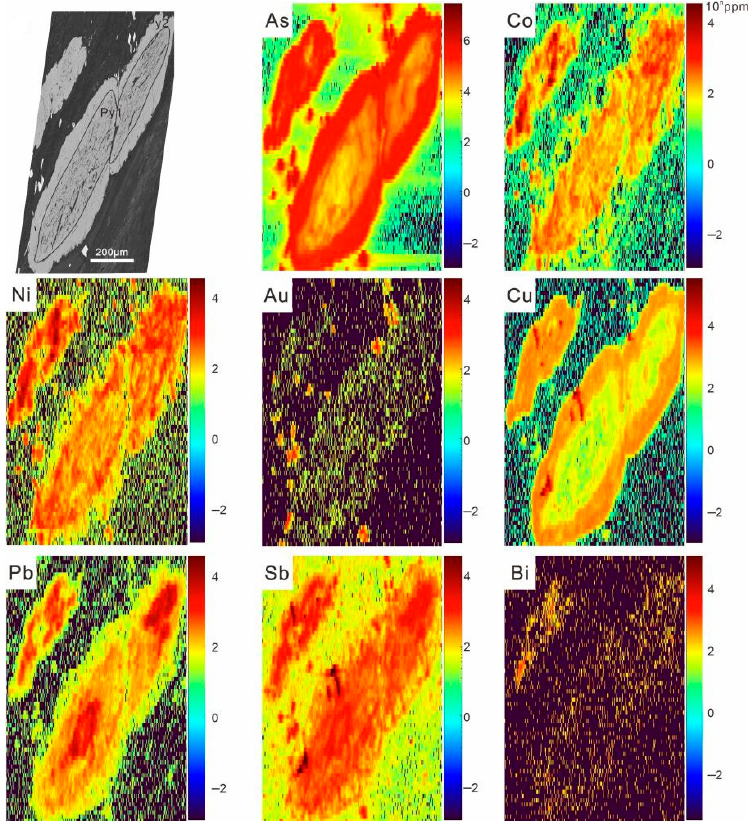
Figure 10. The LA-ICP-MS elemental mapping of Py in the Hongqigou deposit, BSE image of the selected pyrite, other pictures: element distribution of each element.